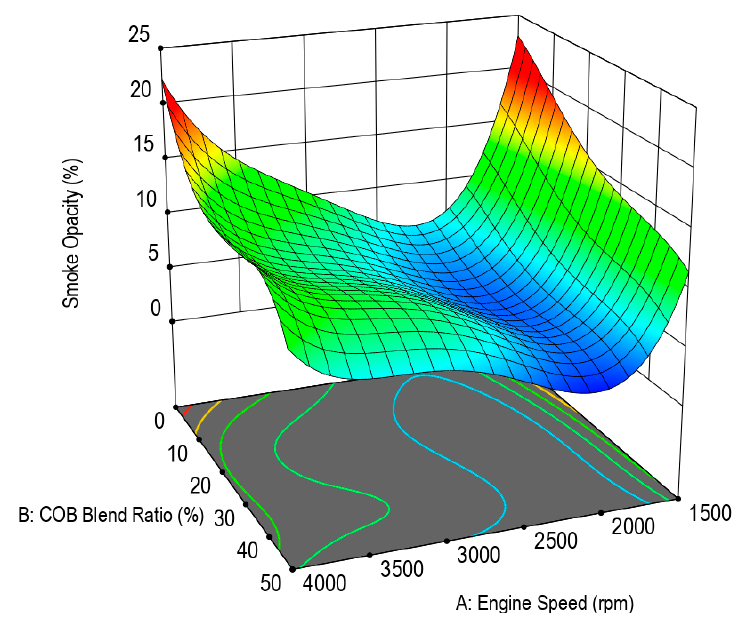
Figure 8. Smoke opacity at various engine speeds for all test fuels. Processes 2020 , 8 , x FOR PEER REVIEW